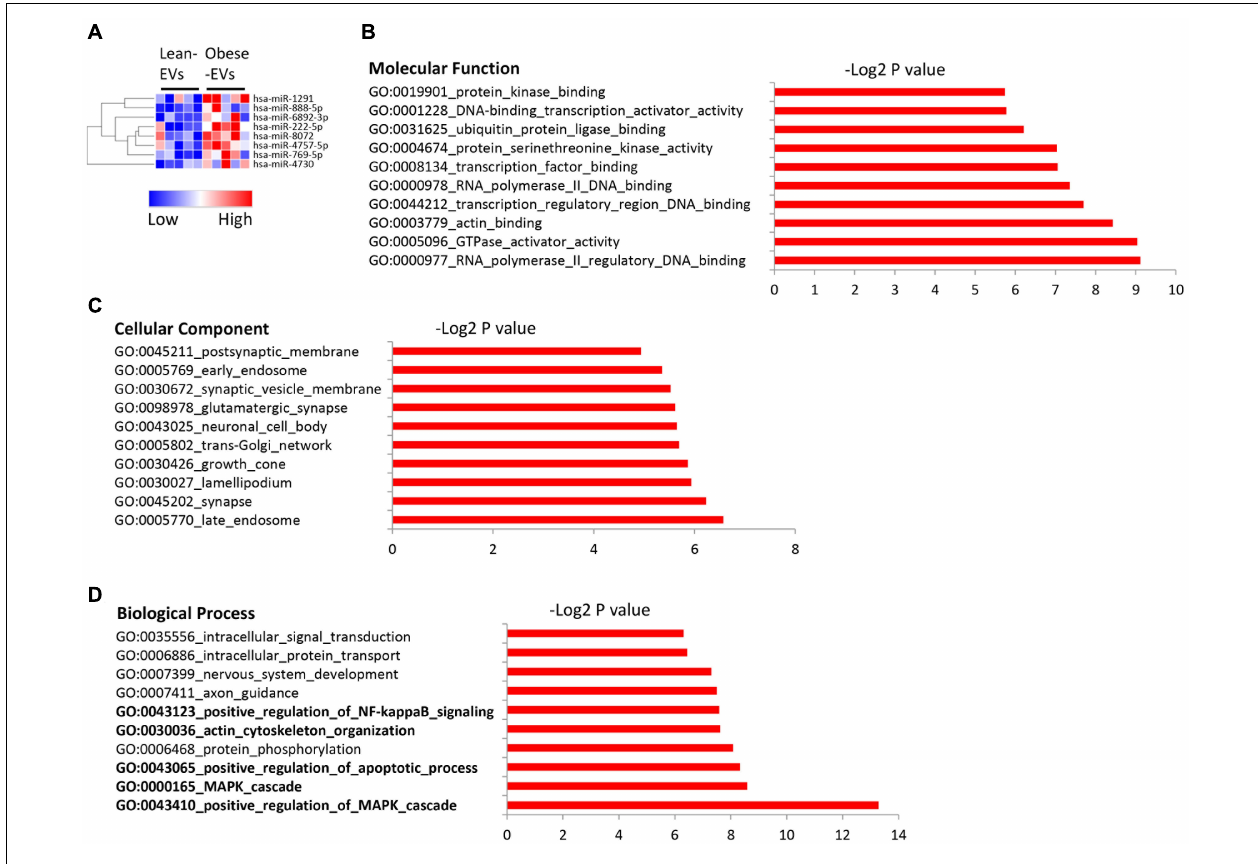
FIGURE 2 | Upregulated miRNA in human ASC-derived EVs and their gene targets. Heat map of miRNAs upregulated in obese-EVs vs. lean-EVs (A) . GSEA analysis of the molecular function (B) , cellular component (C) , and biological process (D) of gene targets of miRNAs upregulated in